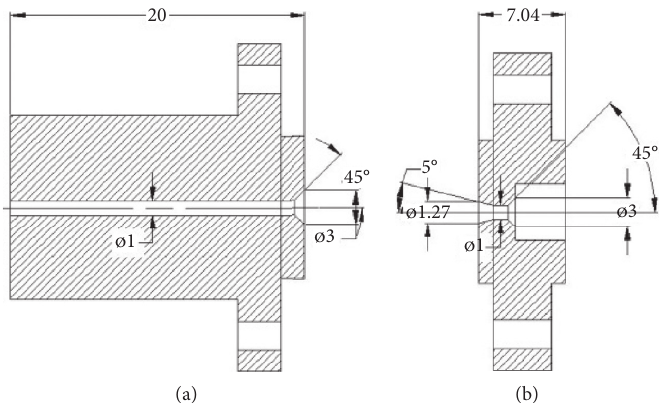
Figure 2: Sonic and supersonic nozzle models installed at the exit of the driven section. (a) Sonic nozzle. (b) Supersonic nozzle.